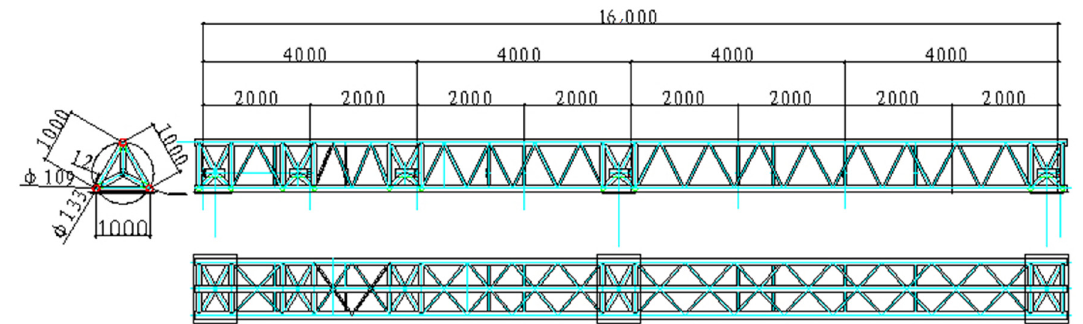
Figure 9. Design of the bracket structure model used in the test.